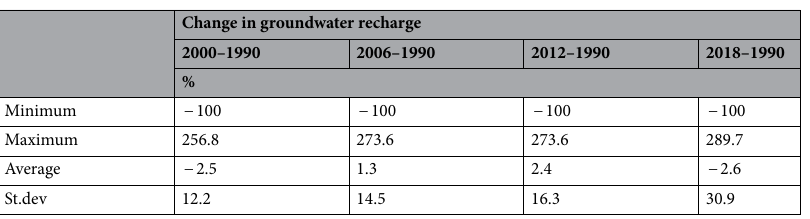
Change in groundwater